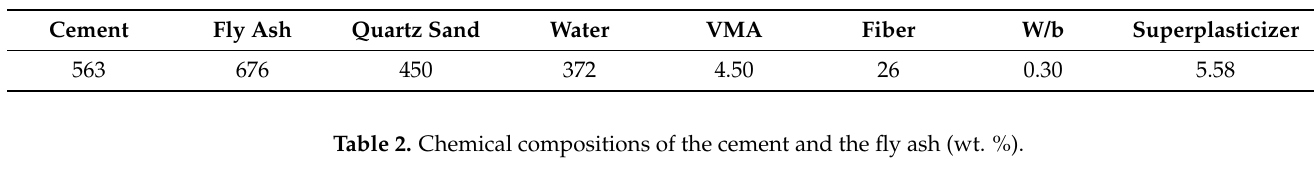
Table 1. Mix proportions of ECC (kg/m 3 ).